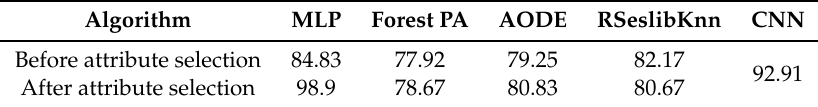
Table 5. The accuracy of each of the applied